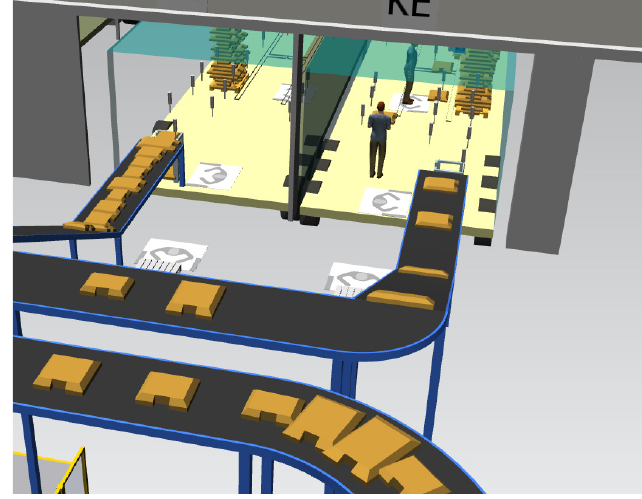
Figure 7. Loading of shipments into the truck after sorting.